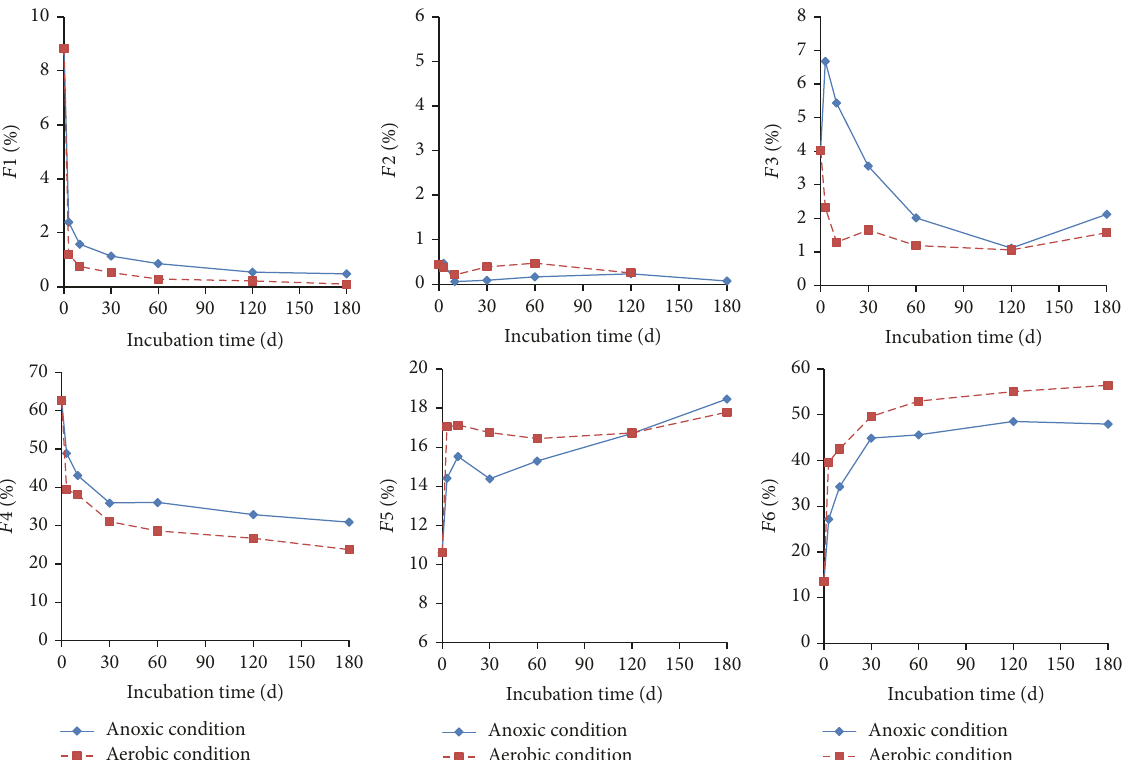
Figure 3: Changes of As fractions in iron grit amended soils under different redox conditions over time (anoxic condition, S IN ; aerobic condition, S IA